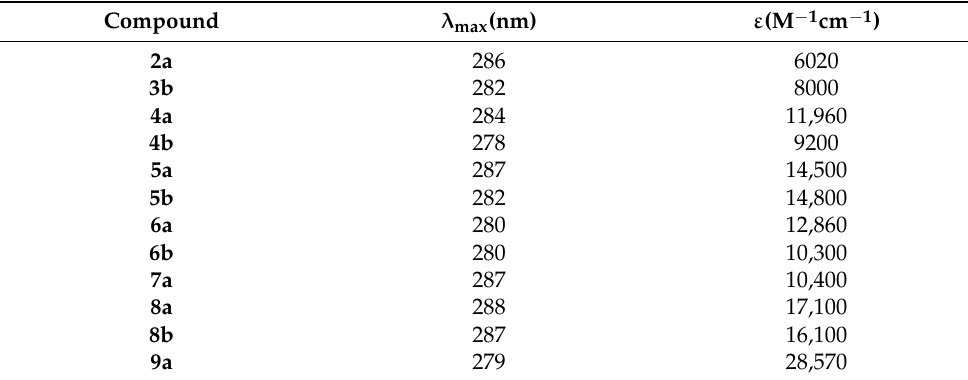
Table 2. Absorption data for compounds 2 – 9 obtained in MeCN (10 − 5 M).